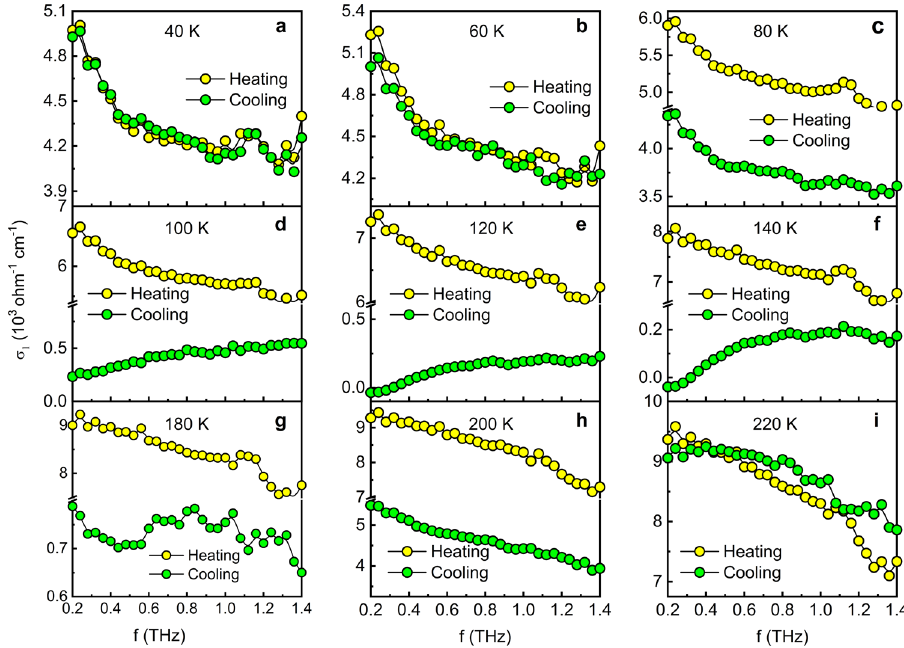
Fig. 4 Heating and cooling THz conductivity spectra for PSNO/LAO (100)_40nm fi lm. a – i Comparison of frequency-dependent real conductivity spectra obtained in heating and cooling sequences at various temperatures; within hysteretic region and beyond hysteretic region for PSNO/LAO (100)_40nm fi lm.